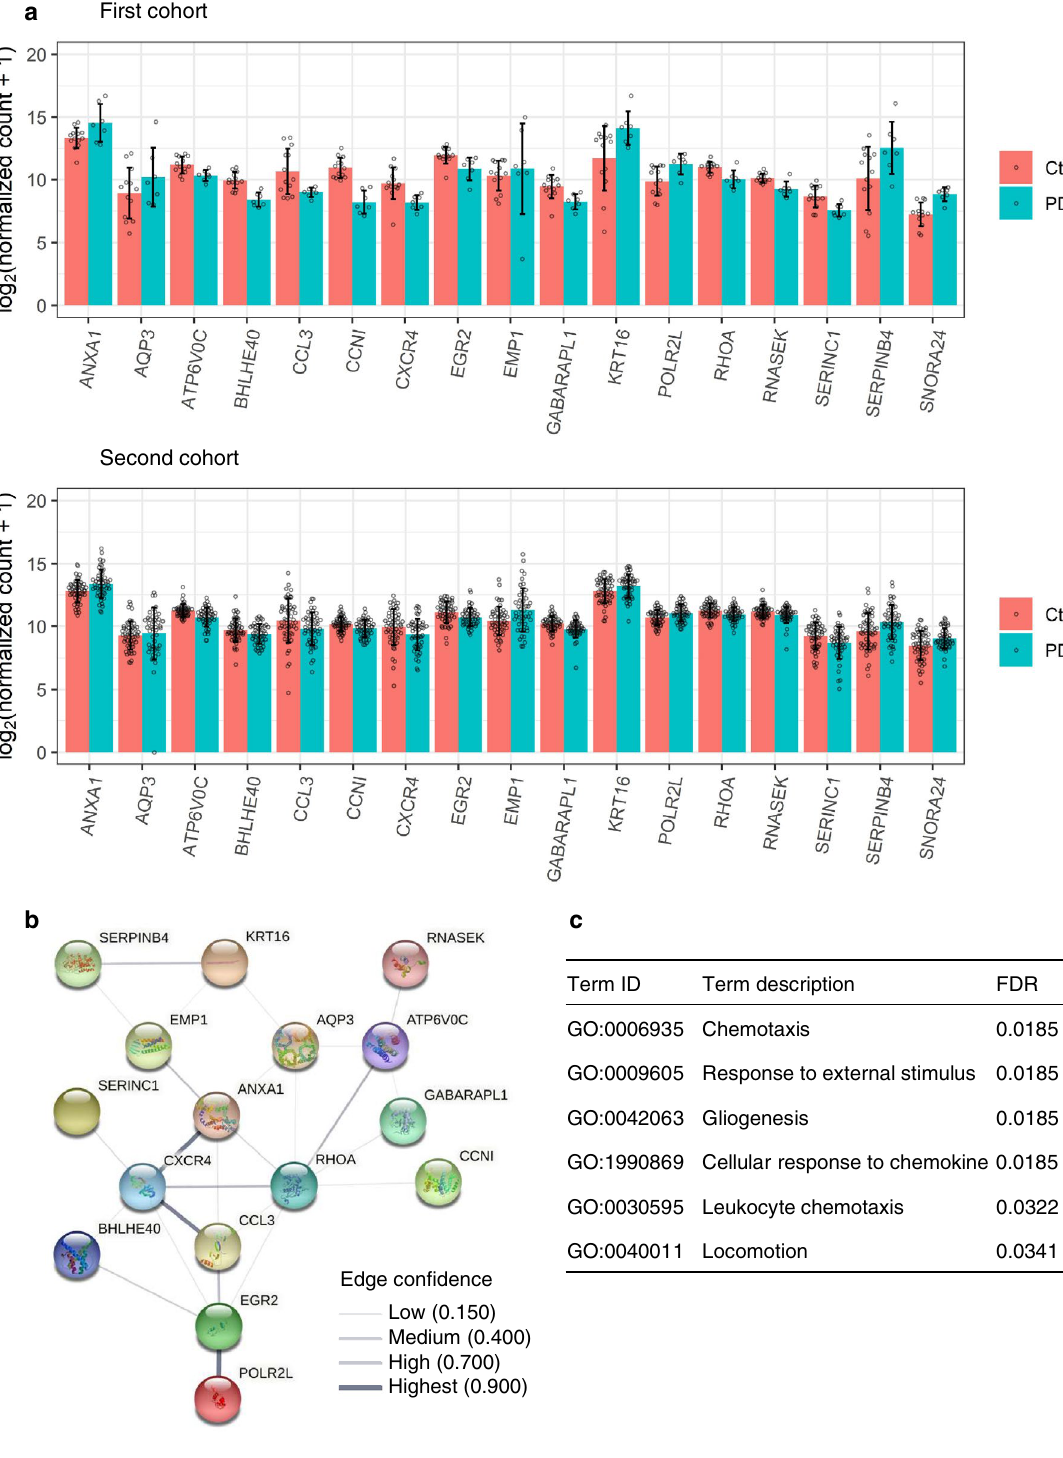
Figure 3. Reproducible genes and protein–protein interactions in both cohorts. ( a ) SSL-RNA expression levels of reproducible genes. Bar plots and error bars show the mean ± standard deviation (SD). Beeswarm plots represent the gene expression levels in each subject. ( b ) Protein–protein interaction analysis in 17 genes. STRING was used to depict the network. The thickness of the line represents the confidence of the edge. ( c ) Significant GO terms for biological process in 17 genes, yielded by STRING. Ctrl healthy controls, FDR false discovery rate, PD Parkinson’s disease. The plots were constructed using ggplot2 and ggbeeswarm R package 19,27